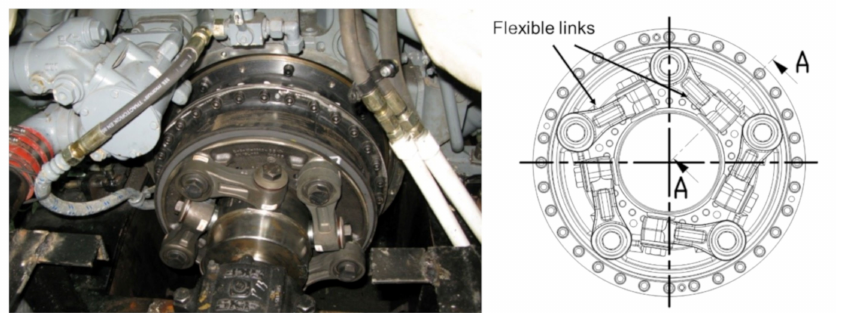
Figure 12. Installation of redesigned Centax elastic coupling with flexible